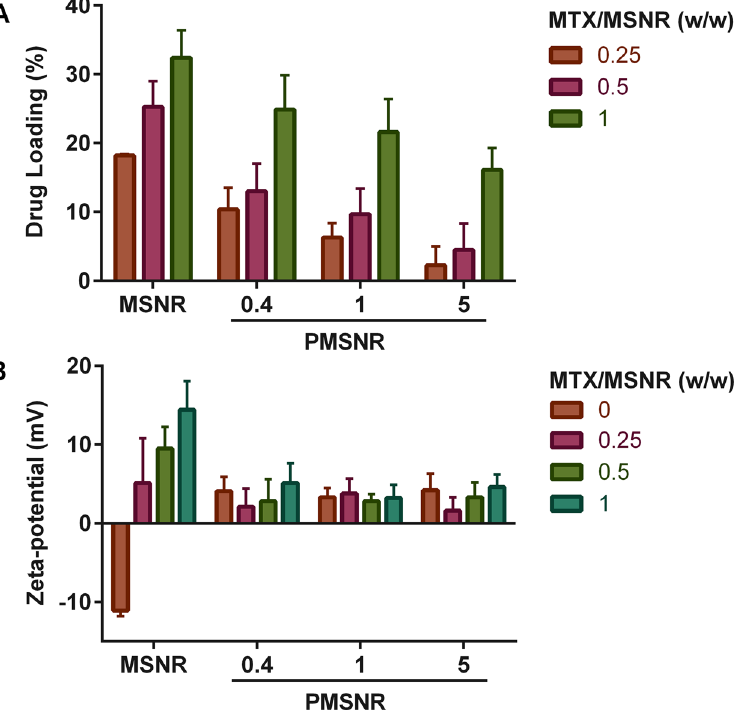
Figure 4. Effect of PEGylation of MSNR on ( A ) MTX loading, and ( B ) zeta-potential. The MTX loading results are presented as mean ± S.D. (n = 3). Zeta-potential was measured in sodium phosphate buffer (20 mM, pH 7.4), and the results are presented as mean ± S.D. (n = 5).